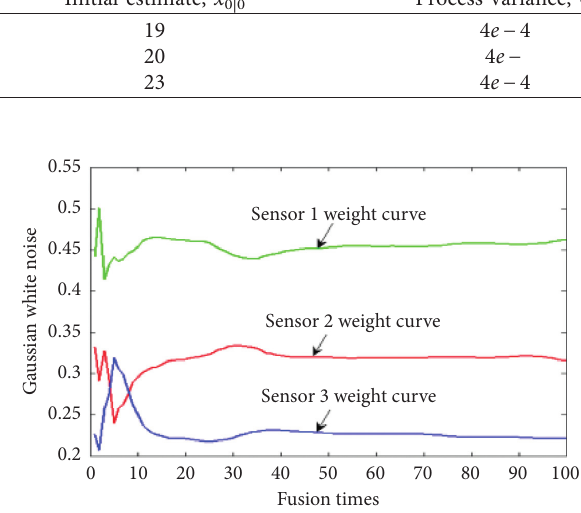
Figure 9: Sensor weight curve of the improved algorithm.